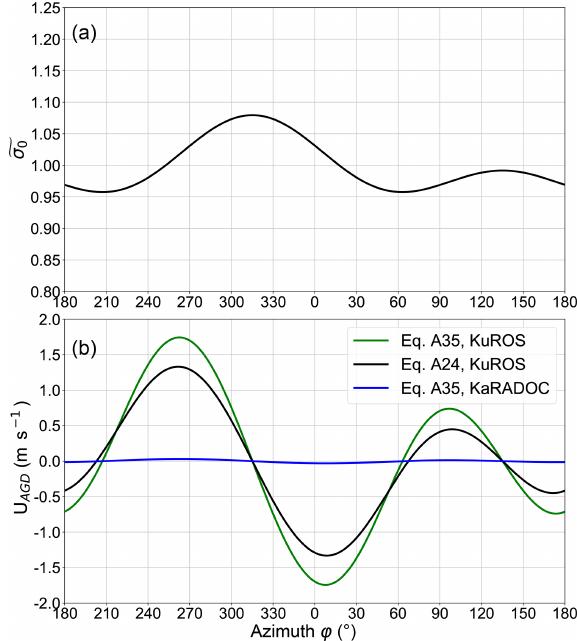
Figure 3. (a) Example of azimuthal variation of (cid:101) σ 0 at a 12 ◦ in- cidence angle, corresponding to the 22 November case (11ms − 1 wind from 140 ◦ ) discussed in Sect. 3, and (b) associated spurious velocity U AGD as a function of look azimuth ϕ b in the case of a port- looking antenna mounted on a platform in constant-altitude flight at 120ms − 1 . For the KuROS case, the green line shows the result of the approximation in Eq. (A35), and the black line shows the result of the full azimuthal integration in Eq. (A24). The blue line repre- sents the result of Eq. (A35) for KaRADOC using the same (cid:101) σ 0 as in the Ku-band